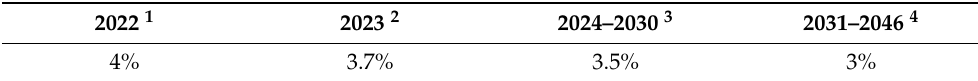
Table 7. GDP growth rate